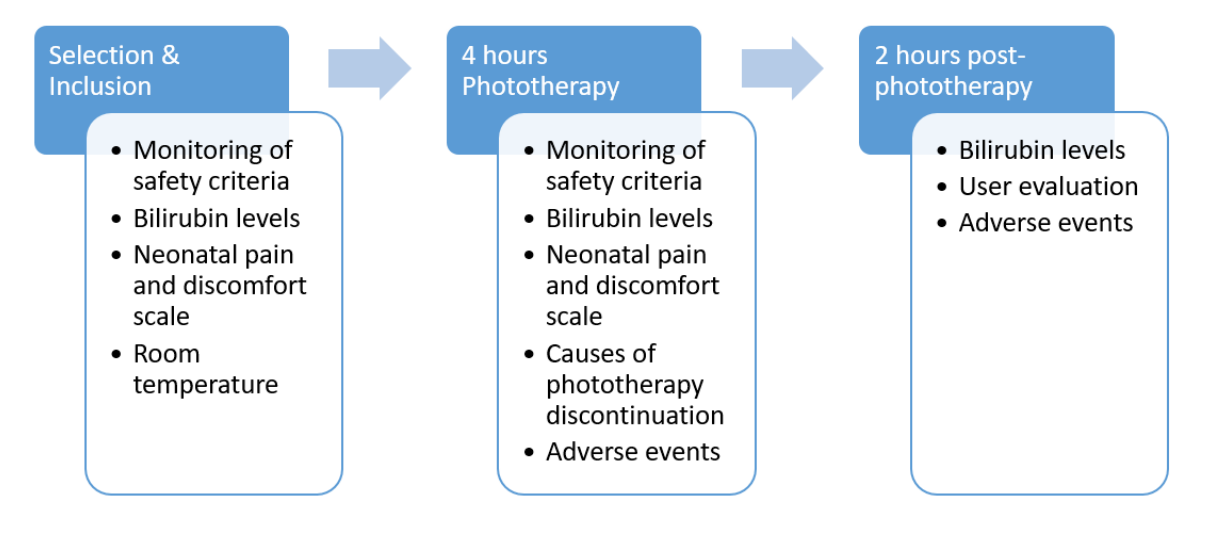
Figure 3. Study design and data